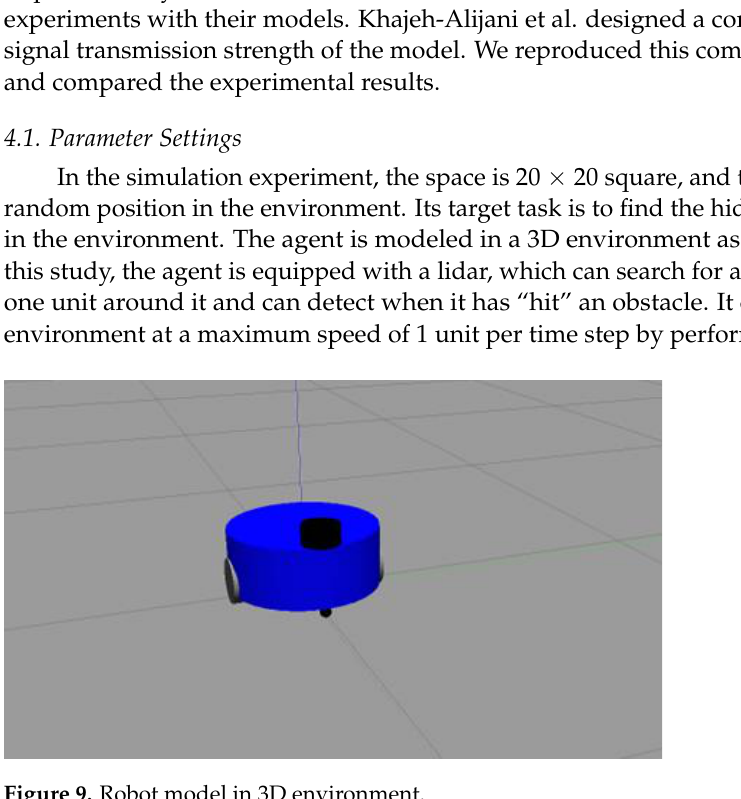
Figure 9. Robot model in 3D environment. Table 1. Parameter settings of the model.